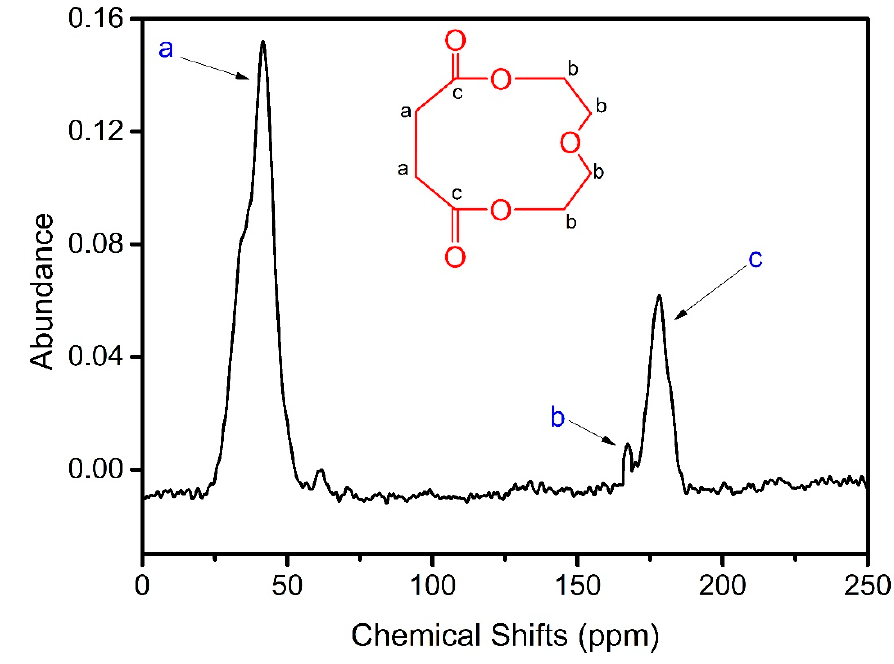
Figure 3. 13 C nuclear magnetic resonance (NMR) spectral analysis of BCE hydrogel adsorbent.